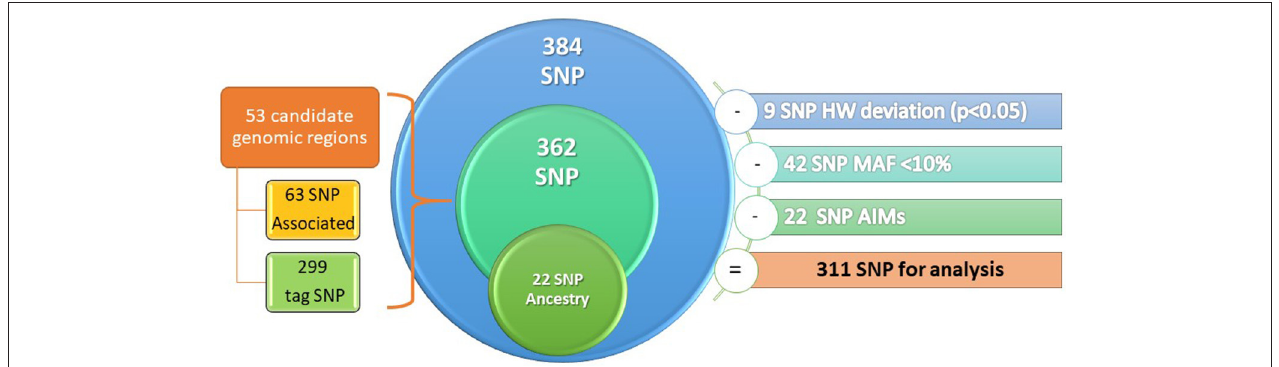
FIGURE 2 | Design of genetic